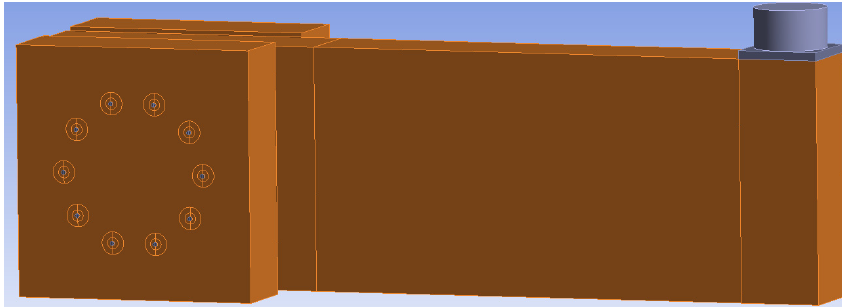
Figure 11. Numerical model for Experiment B, fully threaded screws.